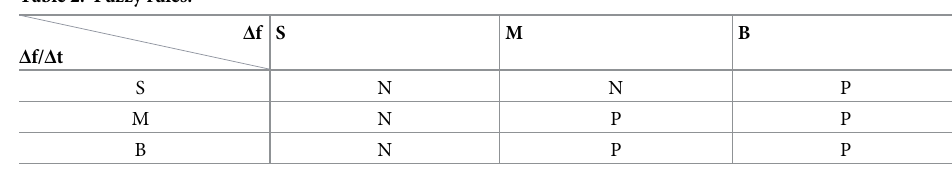
Table 2. Fuzzy rules. S M B Δ f Δ f/ Δ t S N N P M N P P B N P P S is small, M is medium and B is big. P is Positive and N is